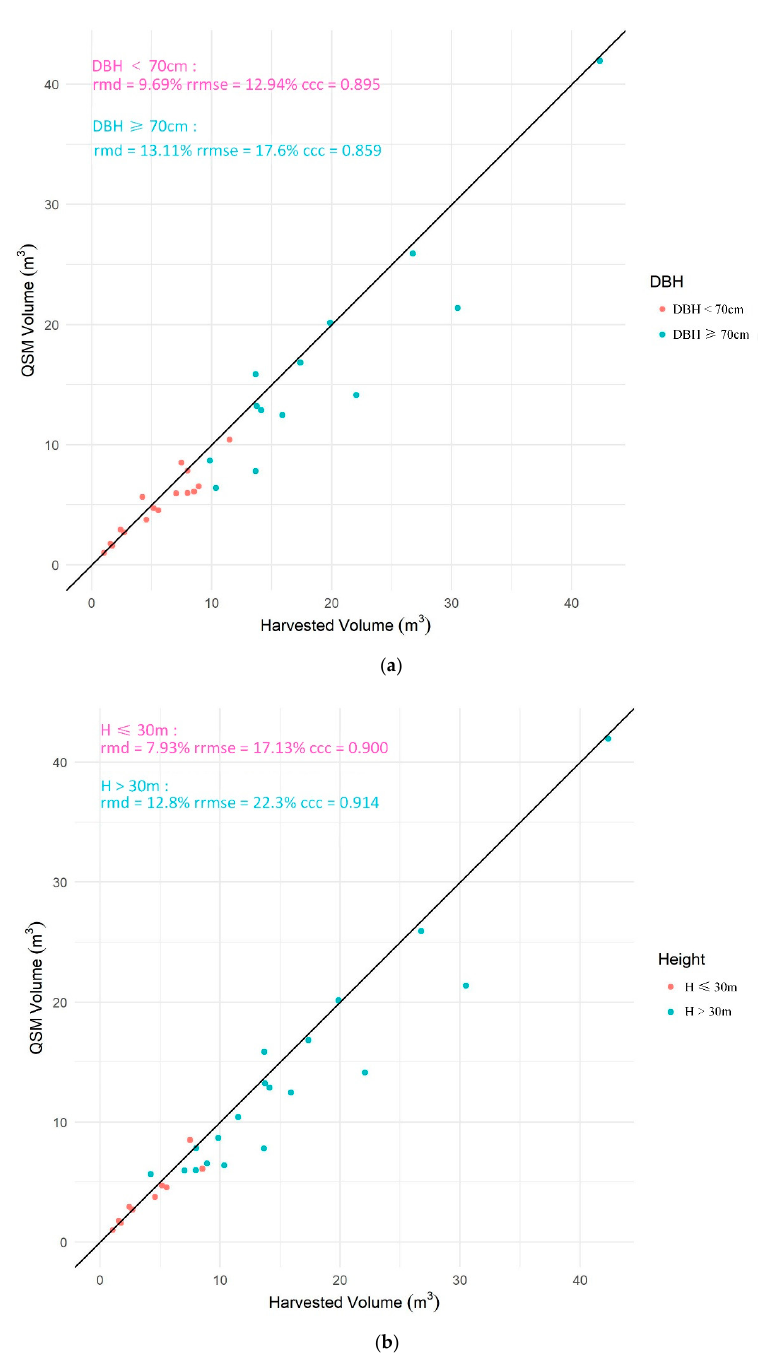
Figure 16. QSM volume comparison among trees with different DBH and tree height. ( a ) QSM volume comparison among trees with DBH smaller than 70 cm and larger than 70 cm. ( b ) QSM volume comparison among trees with height lower than 30 m and higher than 30 m.